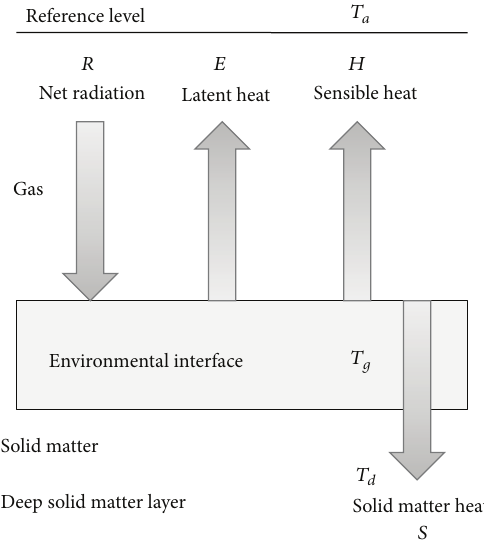
Figure 1: Energy balance equation